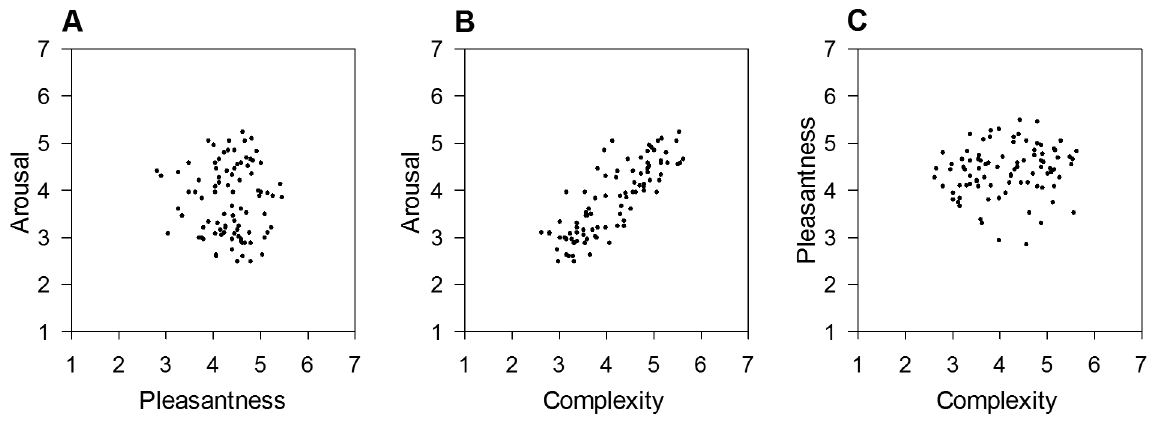
Figure 3. Relationships between pleasantness, arousal and complexity in a set of piano solo music excerpts. Low numbers refer to low ratings of pleasantness, arousal and complexity, respectively. A) Distribution of excerpts of Romantic piano solo music in the pleasantness-arousal space. B) Relationship between mean complexity and arousal ratings. C) Relationship between mean complexity and pleasantness ratings. doi: